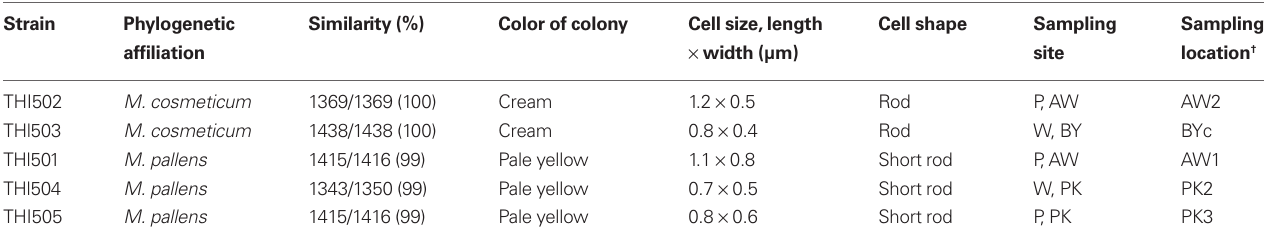
Table 1 | Phylogenetic affiliation by 16S rRNA gene sequences and some phenotypic characteristics of the five sulfur-oxidizing isolates.